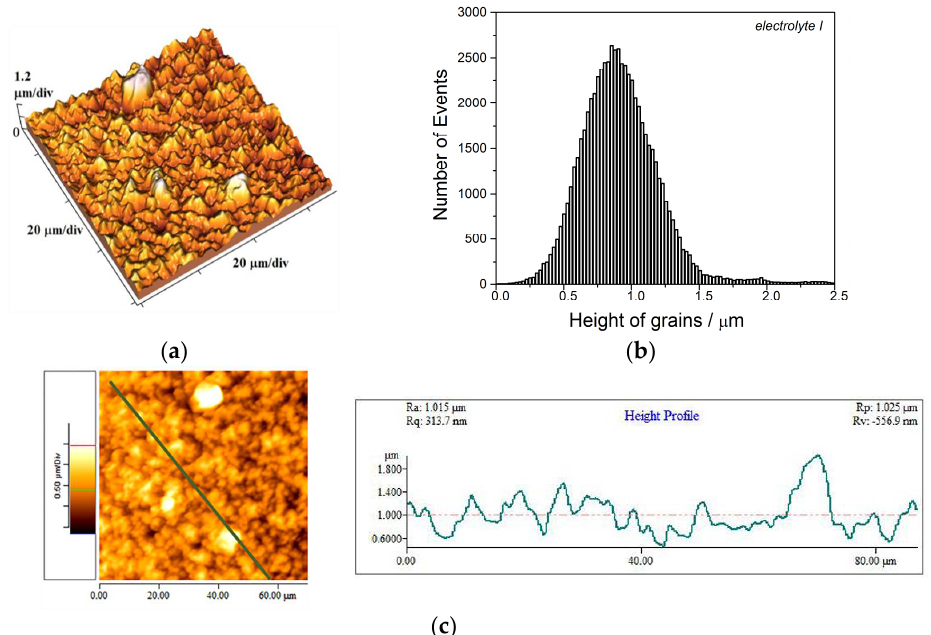
Figure 2. The AFM analysis of 20 µm thick Cu coating obtained by electrodeposition at a current density of 50 mA cm −2 on the brass from electrolyte I : ( a ) the surface topography, ( b ) the histogram and ( c ) line section analysis (X-axis: distance line; Y-axis: height profile). Scan size: (70 × 70) µm 2 .